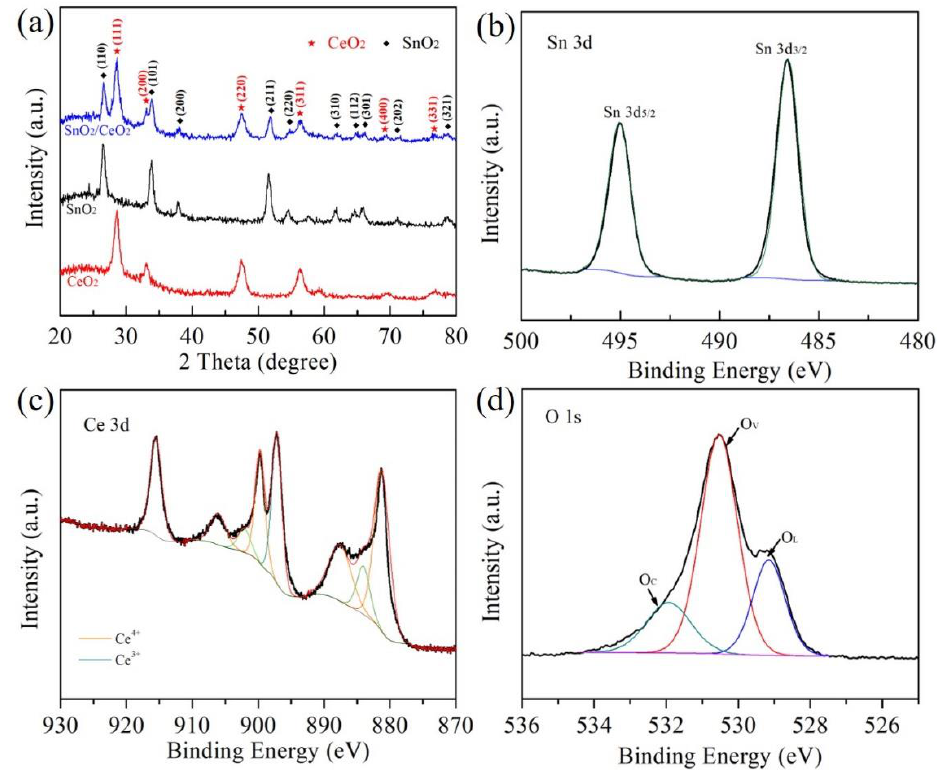
Figure 2. ( a ) XRD patterns of SnO 2 and SnO 2 /CeO 2 composites. XPS spectra of the SnO 2 /CeO 2 com- posite: ( b ) Sn 3d, ( c ) Ce 3d, and ( d ) O 1s. composite: ( b ) Sn 3d, ( c ) Ce 3d, and ( d ) O